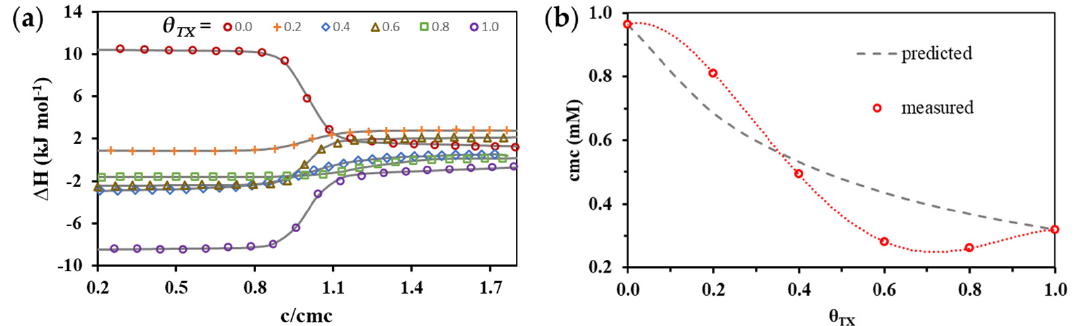
Figure 4. ( a ) Evolution of normalized enthalpograms from pure ( θ TX = 0.0 and 1.0) and mixed ( θ TX = 0.2; 0.4; 0.6 and 0.8) micelle formation at 25 ° C; ( b ) Change of cmc values (red dots) determined from enthalpograms of pure ( θ TX = 0.0 and 1.0) and mixed ( θ TX = 0.2; 0.4; 0.6 and 0.8) micelle formation and calculated [29] cmc values (dashed line) as a function of composition of bulk phase ( θ TX ). Table 1. ITC determined cmc and ∆ mic H values and their standard deviation of the mixed surfactant systems at whole composition ( θ TX ) range at 298 K